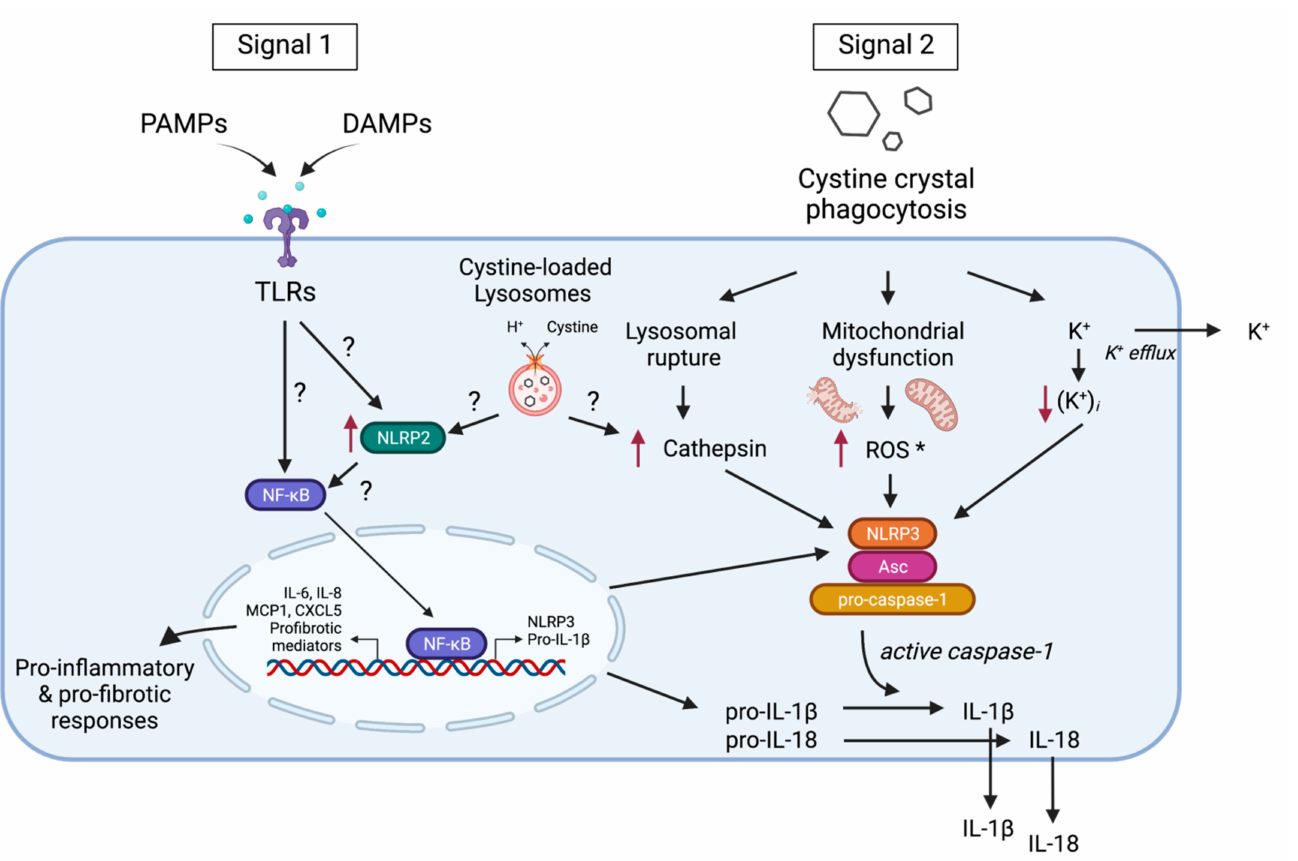
Figure 2. Activation of inflammasome-dependent and independent mechanisms in cystinosis.In vitro, in cultured monocytes, cystine crystals act as an NLRP3 agonist. Inflammasome activation requires two signals. Signal 1 is triggered by PAMPs or DAMPs through TLR/NLR activation and leads to NF- κ B-dependent transcriptional activation of inflammasome components, including NLRP3, and IL-1 β .Signal 2 is triggered by cystine crystals phagocytosis, causing K + efflux leading to hypokalemia, oxidative stress activation by ROS, or lysosomal rupture, and leads to the activation of the NLRP3 inflammasome, which ultimately results in the cleavage and secretion of the pro-inflammatory cytokines IL-1 β and IL-18. A role for the cystine-loaded lysosome in activating inflammasomes has not been demonstrated. Inflammasome-independent mechanisms have also been described in human cystinotic PTECs, in which markedly high levels of NLRP2 have been observed. NLRP2 amplifies pro-inflammatory and profibrotic responses through activation of the NF- κ B signaling pathway. CXCL5, C-X-C motif chemokine 5; DAMPs, damage-associated molecular patterns; IL,